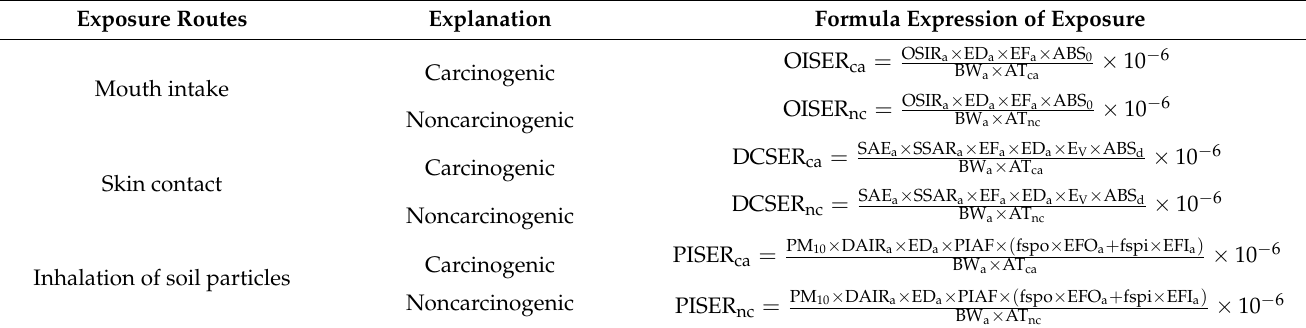
Table 1. Calculating models of soil exposure dose in three soil exposure